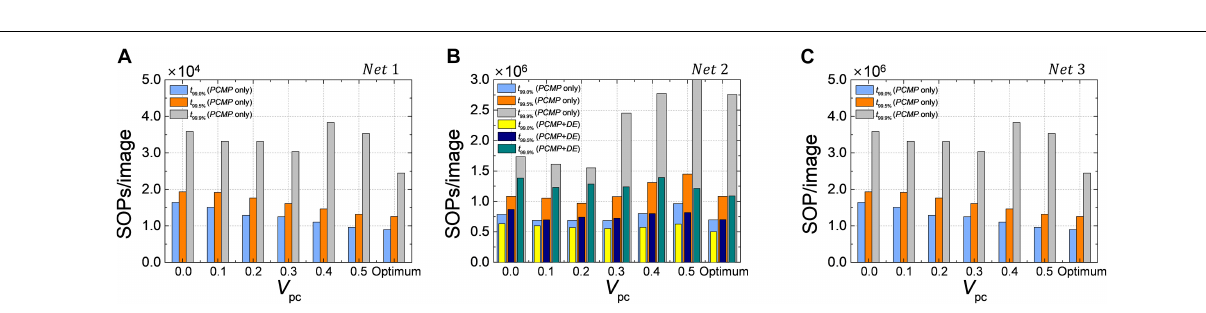
Frontiers in Neuroscience |